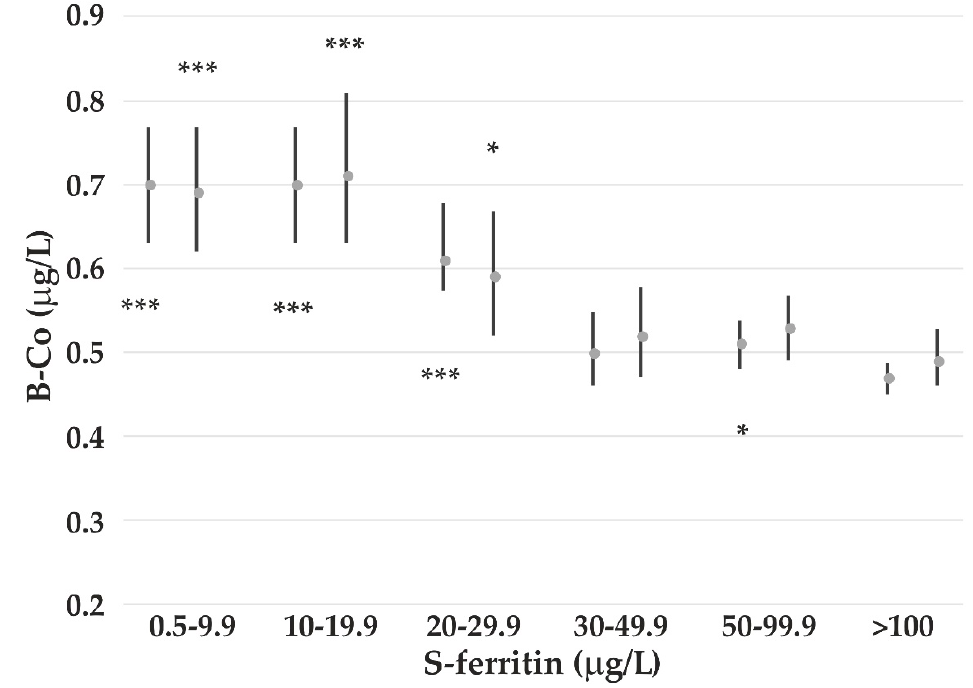
Figure 2. Geometric mean (and 95% CI) B-Co concentrations among all participants (left) and females (right) adjusted for age and reindeer consumption. The p -values (*** p < 0.001; * p < 0.05) refer to the subgroup with S-ferritin >100 µg/L as reference for all participants and women, respectively. B-Mn was also associated with the concentrations of B-Pb. When stratifying the participants into tertiles with low, medium, and high S-ferritin and low, medium, and